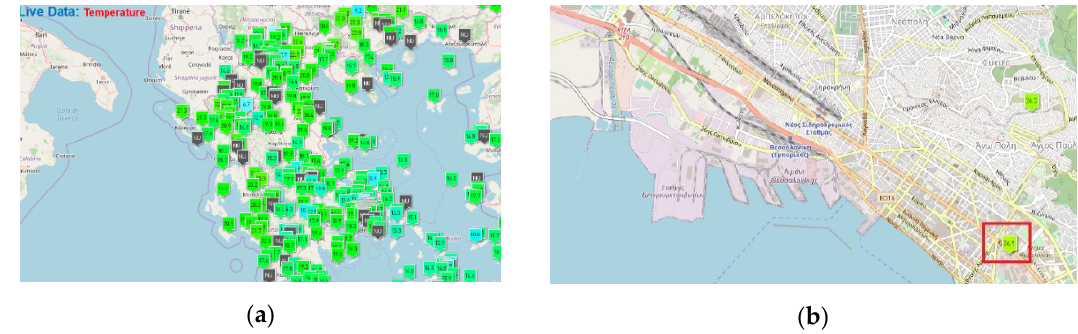
Figure 10. Selection of sensor data source for weather. ( a ) Global meteo sensor stations distributed throughout Greece; ( b ) Sensor selected close to the gates of the Port of Thessaloniki. Table 3. Summary of data used in the